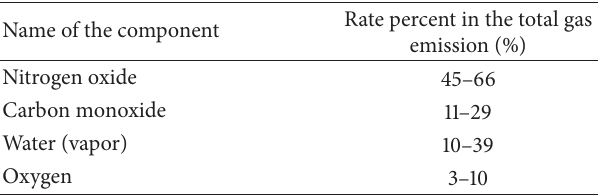
Table 2: Components of the gases released from the cement fac- tories.